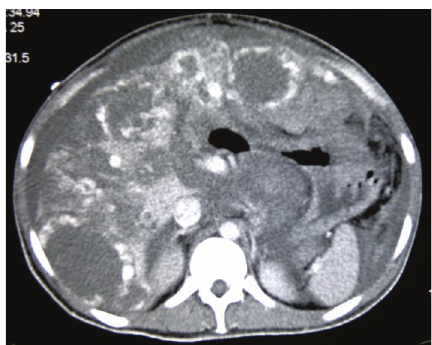
Figure 3: CD117 positivity in the seminomatous component.